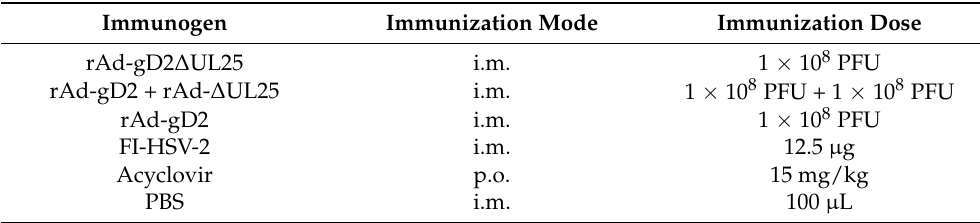
Table 1. Immunized with recombinant adenovirus-based